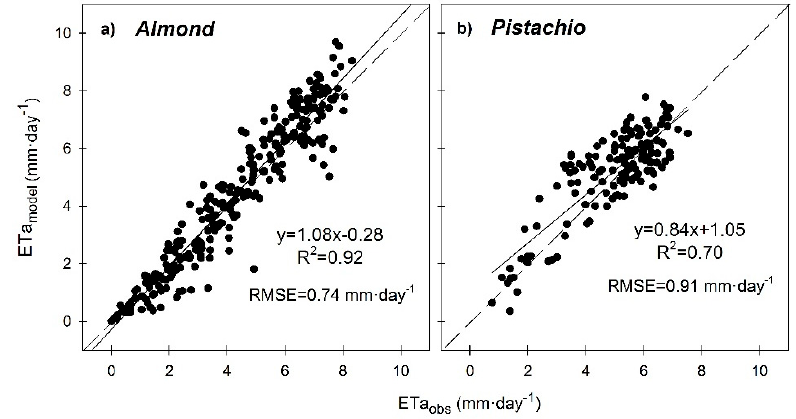
Figure 11. Comparison between observed (flux towers) and modelled actual daily evapotranspiration (ETa obs , ETa model ) in ( a ) almonds and ( b ) pistachios.